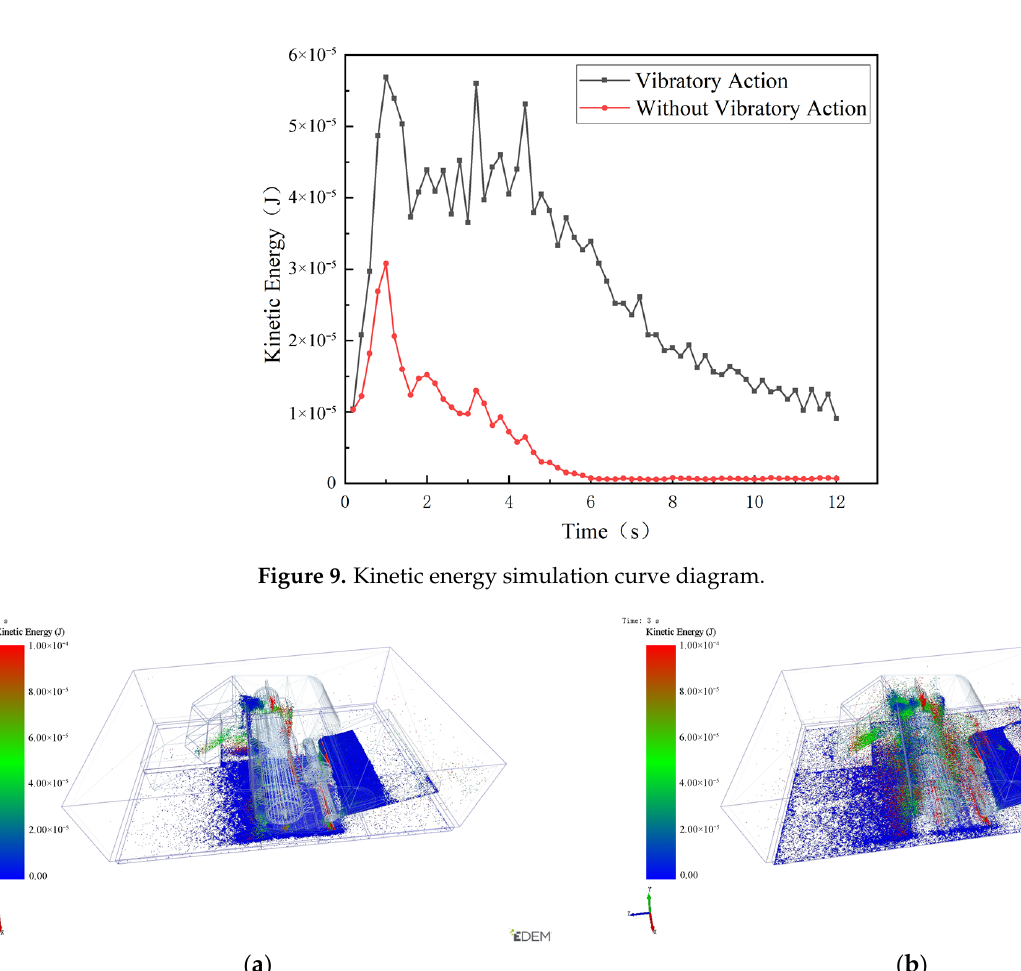
Figure 10. Kinetic energy simulation comparison diagram: ( a ) sandy soil removal process without vibratory action; ( b ) sandy soil removal process with vibratory action.